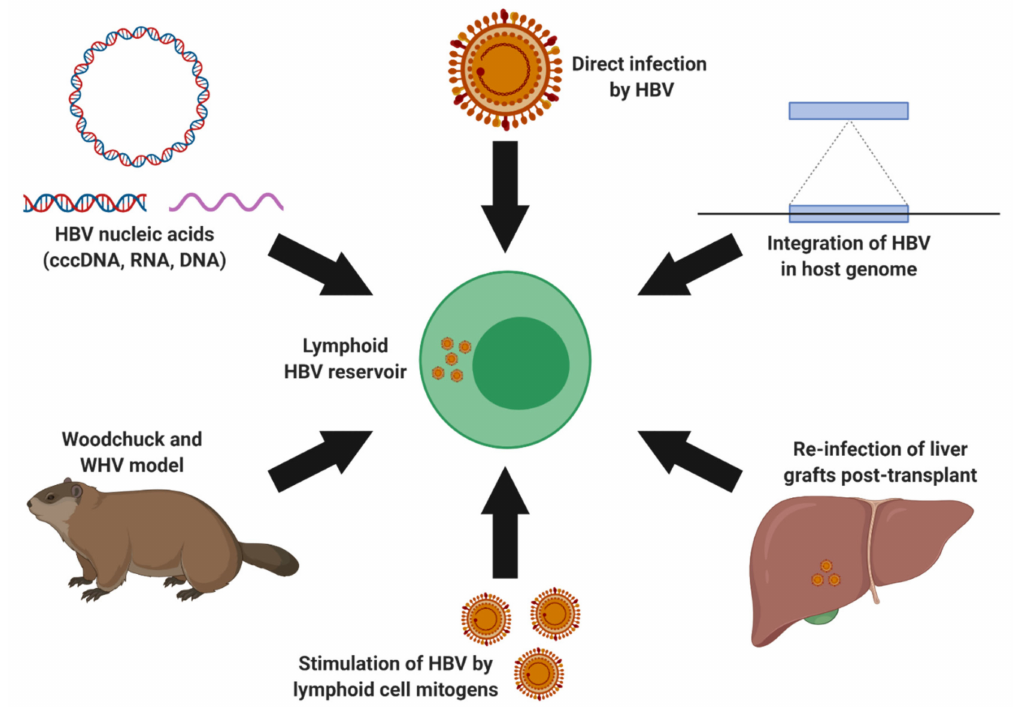
Figure 3. Evidence for a lymphoid HBV reservoir. The woodchuck and woodchuck hepatitis virus (WHV), a useful animal model system for hepadnaviruses, has established lymphoid infection